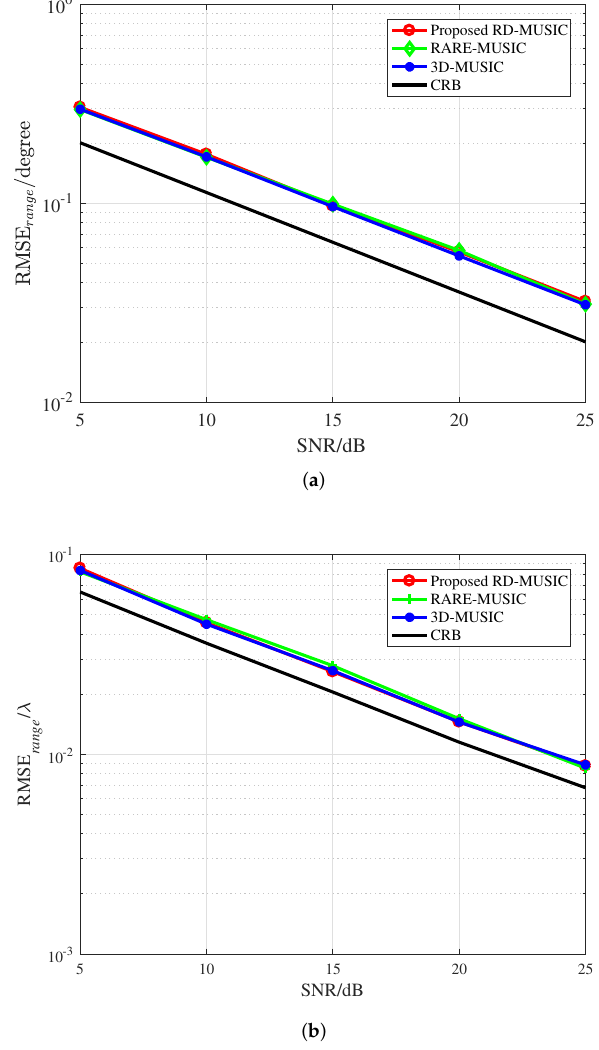
Figure 3. RMSEs versus SNR. ( a ) DOA estimation. ( b ) Range